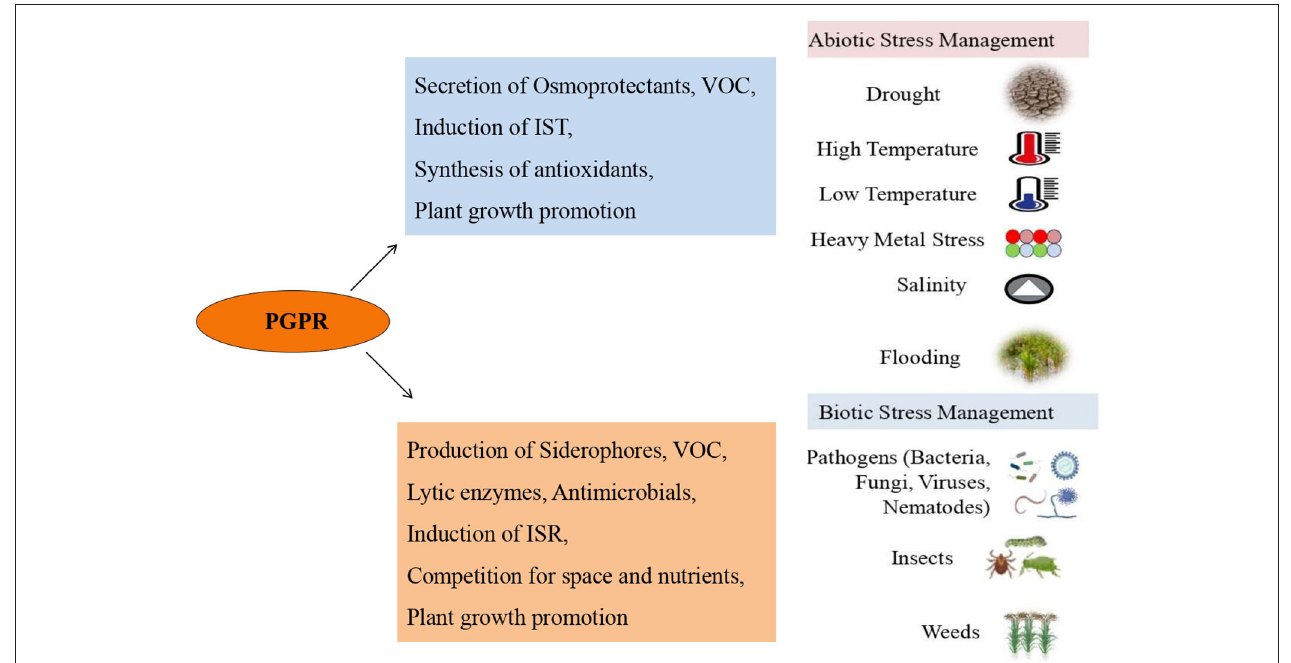
FIGURE 3 | Mechanisms of PGPR mediated biotic and abiotic stress tolerance in